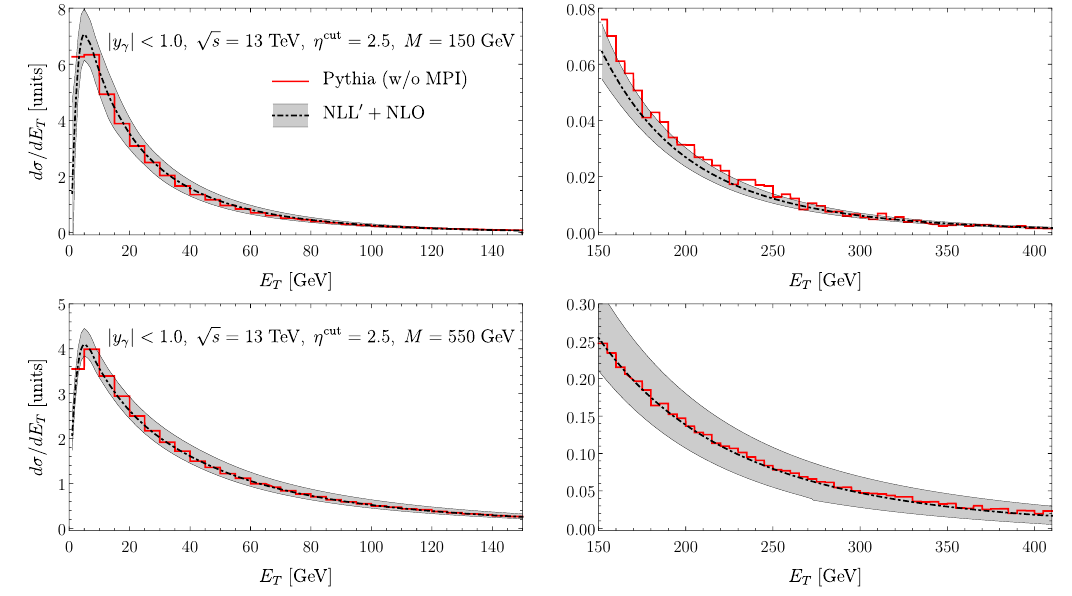
Figure 1 . The NLL-prime resumed distributions evaluated from eq. (2.35) (black dot-dashed) compared against the result from Pythia partonic distributions (red